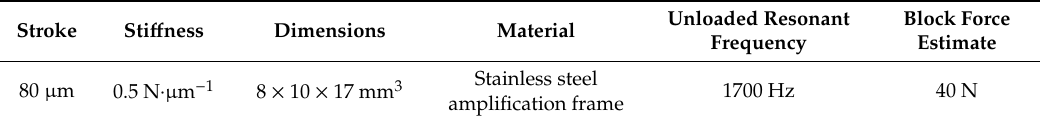
Figure 5. SEM photographs of components in piezoelectric microvalve: ( a ) the microchannel [43]; ( b ) the silicon valve core and the sealing ring [44]; ( c ) the hole with serpentine groove patterns [42]. Table 1. Piezoactuator specifications [41].